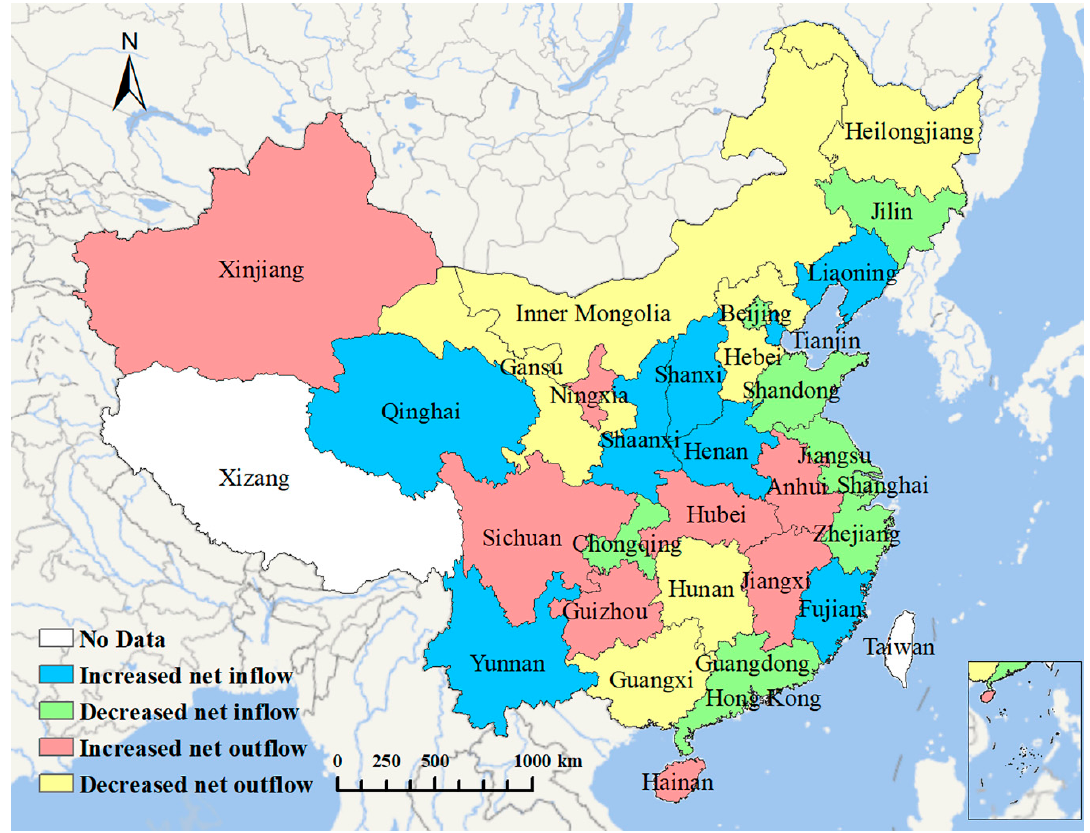
Figure 7. Changes in VW inflows/outflows in China from 2007 to 2010.